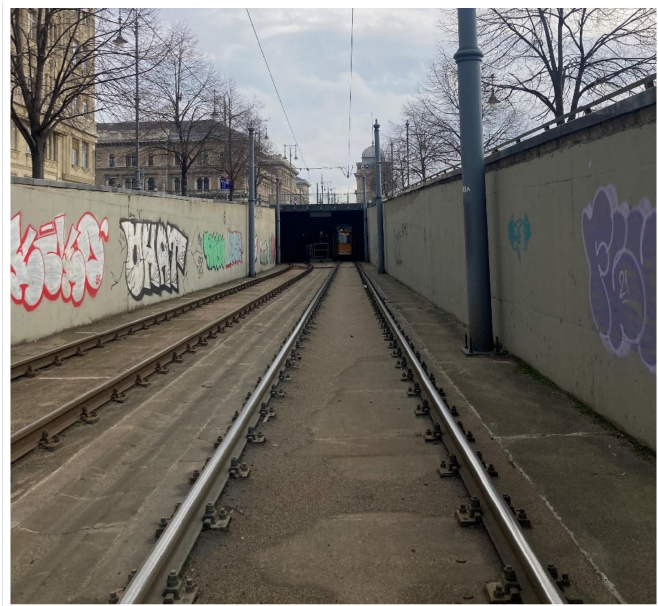
Figure 8. Photo of Section #7 (own